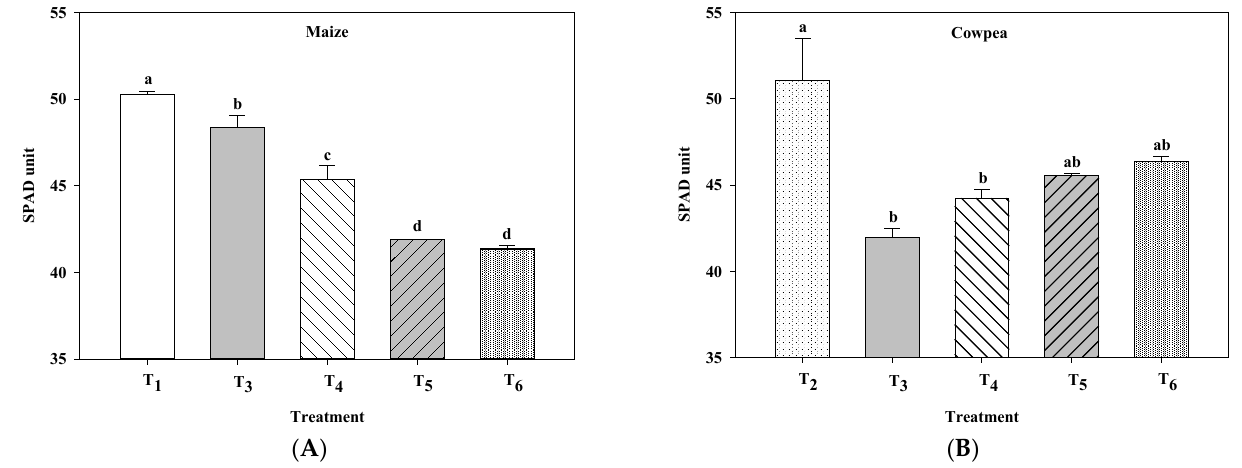
Figure 2. Chlorophyll content measured as soil and plant analysis development (SPAD) values in maize (panel ( A )) and cowpea (panel ( B )) leaves. For treatment abbreviations, see Figure 1. Different letters above the bars indicate statistically significant differences at Tukey’s HSD (a = 5%). Error bars represent the standard error of means, N = 3.